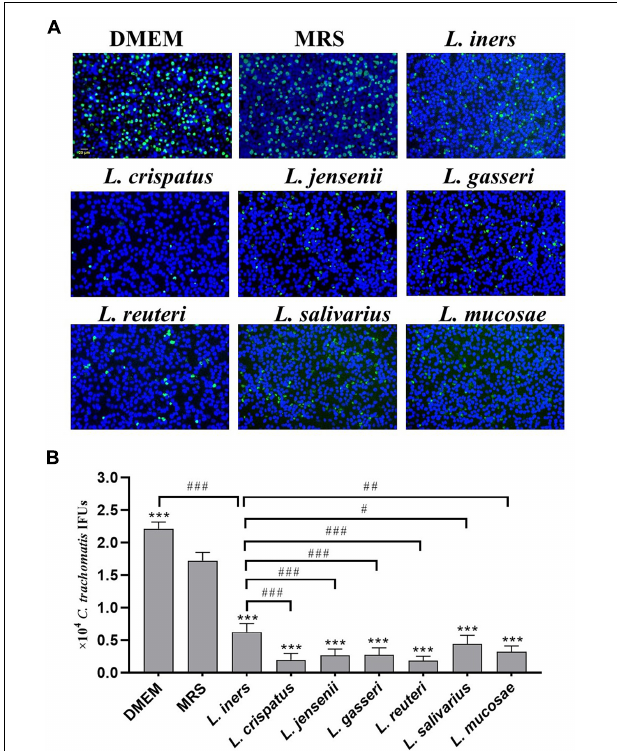
FIGURE 1 | Effect of lactobacillus cell-free culture supernatants on C. trachomatis infectivity. C. trachomatis EB was pre-incubated with either a DMEM cell culture medium (control), an MRS bacterial culture medium (control), or sterile-filtered cell-free culture supernatants collected from overnight cultures of L. iners, L. crispatus, L. jensenii, L. gasseri, L. reuteri, L. salivarius , and L. mucosa prior to HeLa cells infected with C. trachomatis . The infected cells were processed for immunofluorescence detection of the C. trachomatis E organism (green), and DNA (blue) (A) . C. trachomatis IFUs were scored by fluorescence microscopy (B) . Each bar represents the mean ± SD of the IFUs from three independent experiments. *** p < 0.001 vs. MRS control; # p < 0.05, ## p < 0.01, and ### p < 0.001 vs. L. iners supernatants treatment (one-way